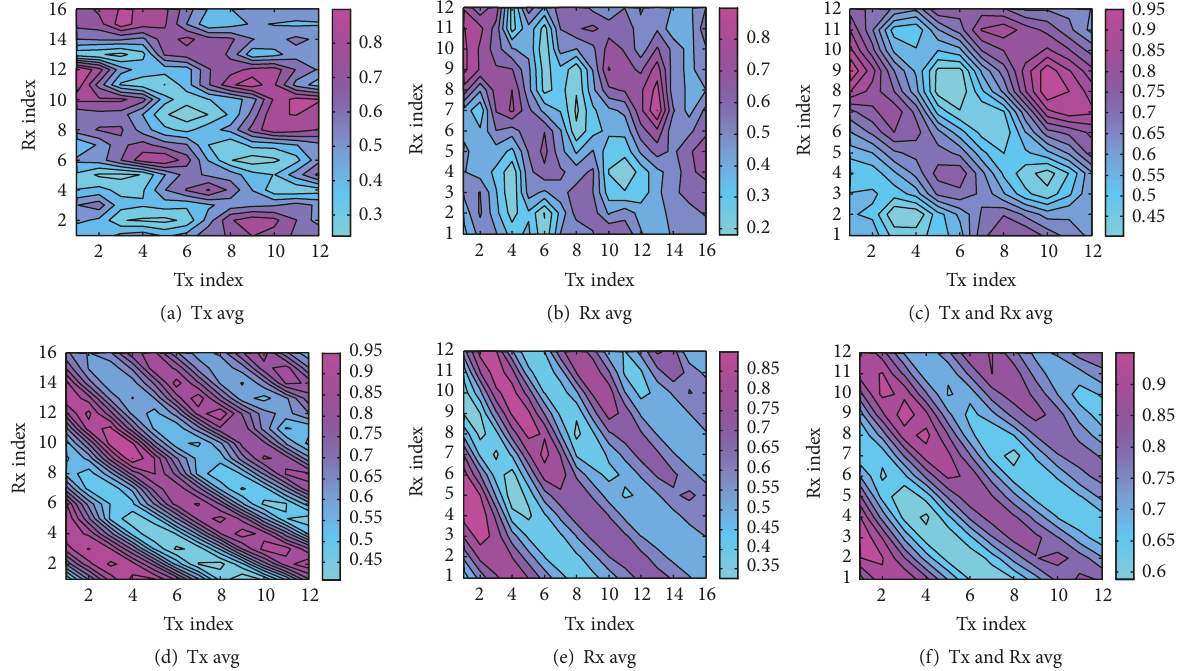
Figure 17: Measurement (a)–(c) and simulated (d)–(f) amplitude average results over 4 antennas on Tx and Rx and both on Tx and Rx antennas at 25 m.